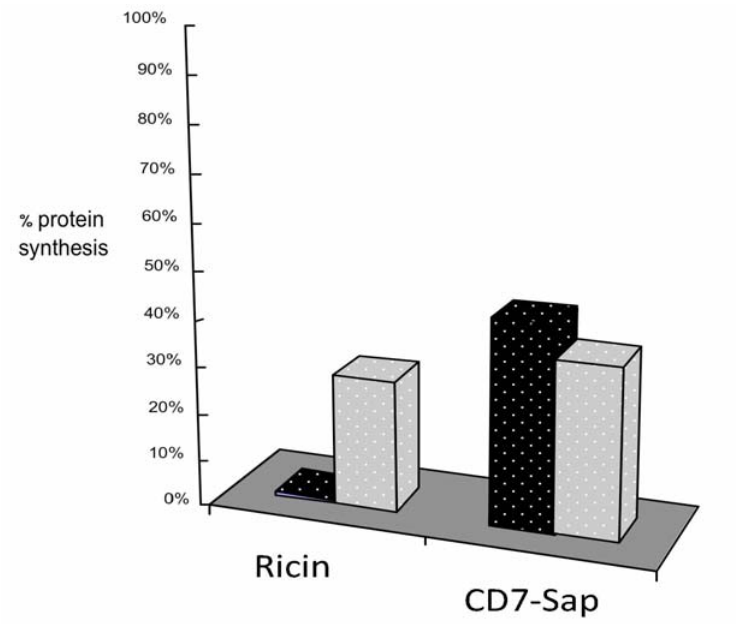
Figure 6. Four-hour protein synthesis inhibition assay induced by CD7-SAP ITx or ricin in the presence (5  g/mL) or in the absence of BFA. Cytotoxicities were measured after 4 h incubation with Ricin (10 − 10 M) and CD7-SAP (10 − 8 M) by the incorporation of 3 H-leucine in the presence or in the absence of BFA. Data are reported as percent protein synthesis with respect to control untreated cells. Black histogram bars represent cells exposed to toxins in the absence of BFA, light grey histogram bars represent cells exposed to toxins following BFA treatment.